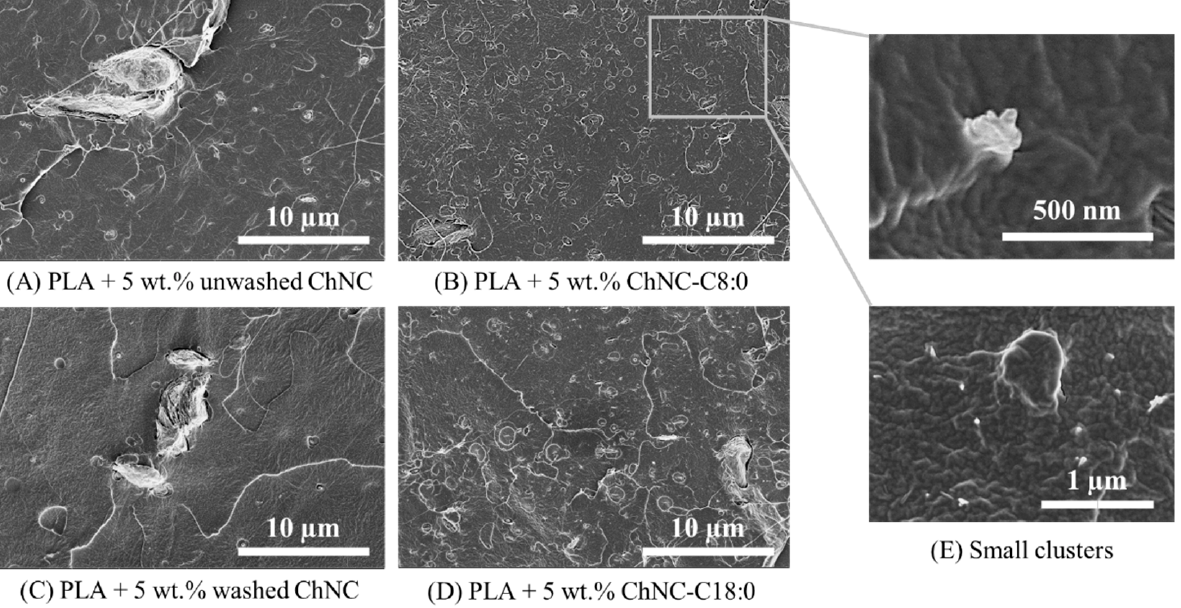
Figure 5. Scanning electron microscopy pictures of PLA containing ( A ) 5 wt.% unwashed ChNC, ( B ) 5 wt.% ChNC-C8:0, ( C ) 5 wt.% washed ChNC, ( D ) 5 wt.% ChNC-C18:0. ( E ) Samples containing ChNC-C8:0 and ChNC-C18:0 had many small aggregates with a size of ~500 nm.